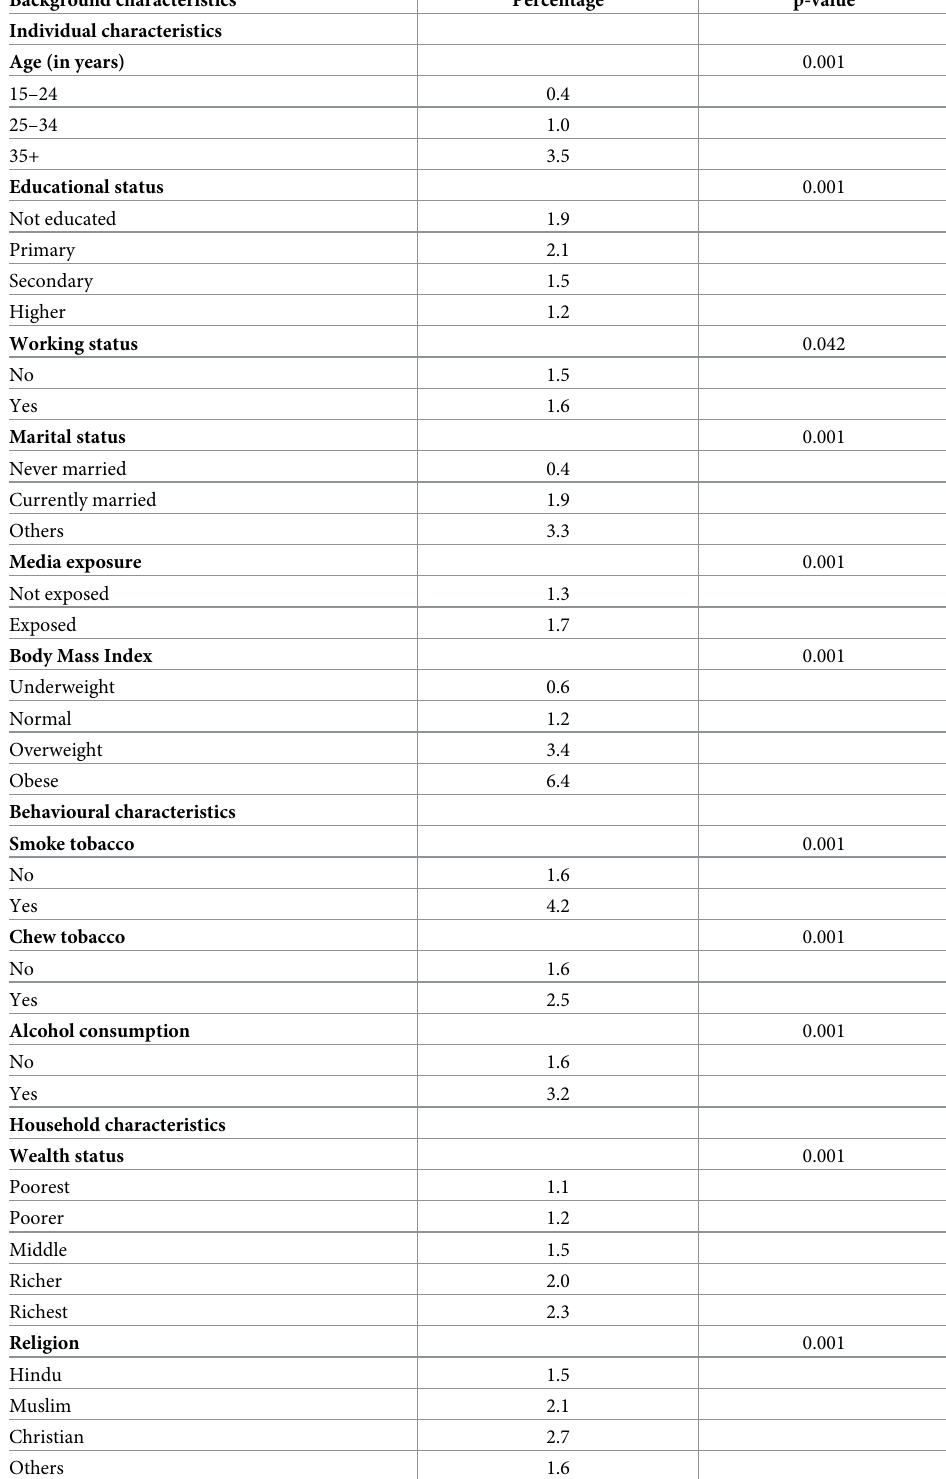
Table 2. Percentage of women aged 15–49 years suffering from multi-morbidity in India,